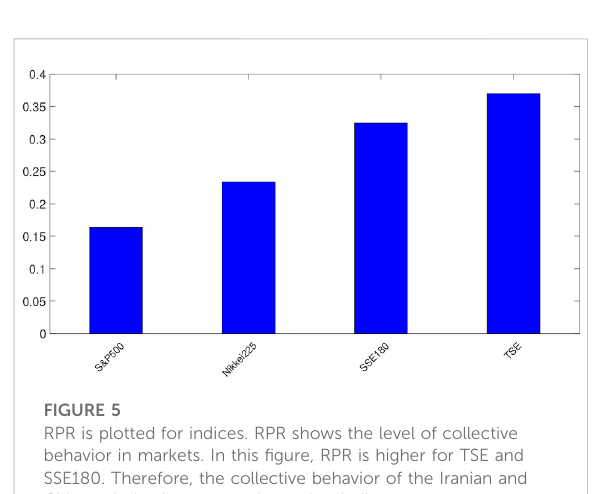
FIGURE 5 RPR is plotted for indices. RPR shows the level of collective behavior in markets. In this fi gure, RPR is higher for TSE and SSE180. Therefore, the collective behavior of the Iranian and Chinese index is stronger than other